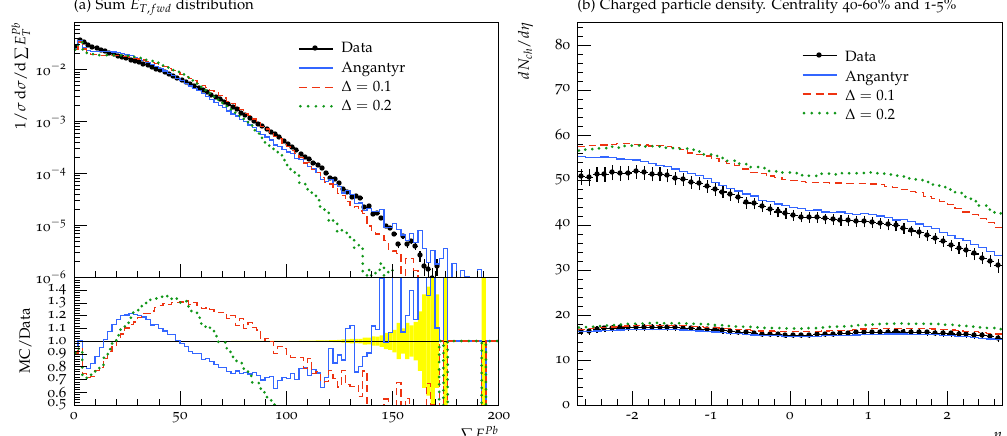
Figure 23 . Comparison between di(cid:11)erent choices of (cid:1) for generation of secondary absorptive sub- events. Variations shown for (a) the summed transverse energy in the Pb direction ( 3 : 2) and (b) the average charged multiplicity as a function of pseudo-rapidity for pPb collisions at (cid:0) p s NN = 5 : 02 TeV. Data points are from ATLAS [26]. Full blue line is the default choice of (cid:1) = 0, while the red dashed and green dotted lines corresponds to (cid:1) = 0 : 1 and 0 : 2 respectively. In (b) the lines on the bottom and top corresponds to the 40{60% and 1{5% centrality bins